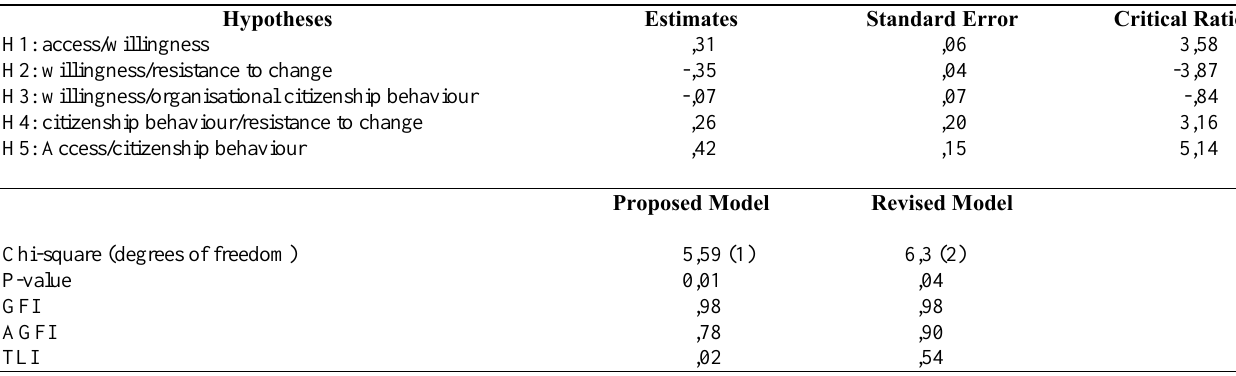
Table 2: Standardised Estimates, Standard Error, Critical Ratios, and Goodness-of-Fit